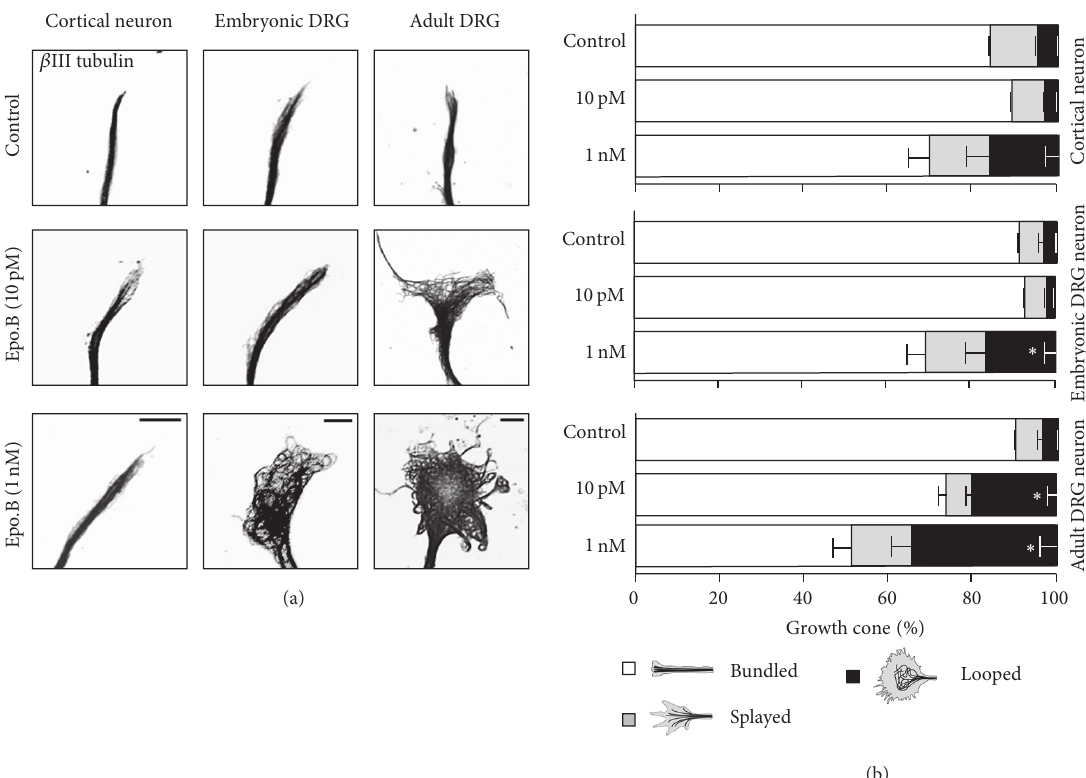
Figure 5: Epothilone B induces changes in growth cone MT structure. (a-b) Embryonic (E15.5) cortical neurons, embryonic (E13.5) DRG neurons, or adult DRG neurons were cultured in the absence or presence of epothilone B (either 10 pM or 1nM) and were fixed, followed by immunostaining with anti-Tuj1 antibodies. Exposure time has been adjusted for each image to optimize the visibility of the MT network. Representative images (a) and quantifications of growth cone MT network (b) are shown. Scale bar, 10 𝜇 m. ∗ 𝑝 < 0.05, statistically not